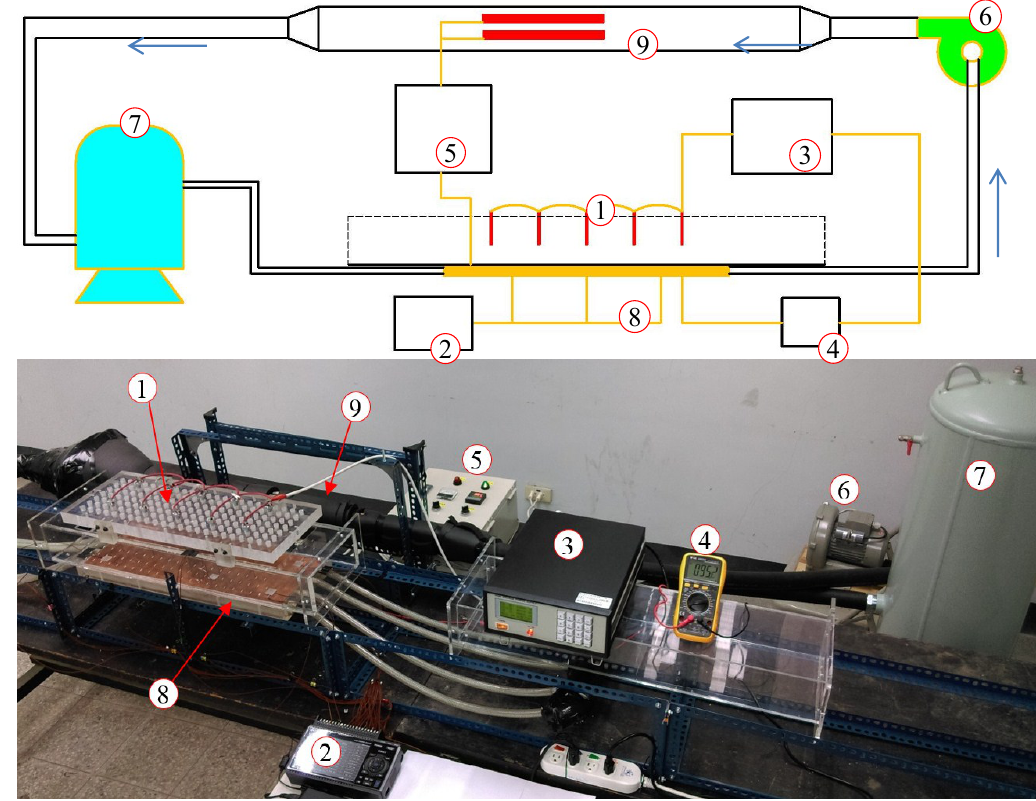
Figure 5. The experimental setup. 1. High voltage needle electrode system; 2. Data acquisition instrument; 3. High voltage power supply; 4. Micro ammeter; 5. Temperature controller; 6. Air blower; 7. Surge tank; 8. Air heating plate; 9. Heating channel.